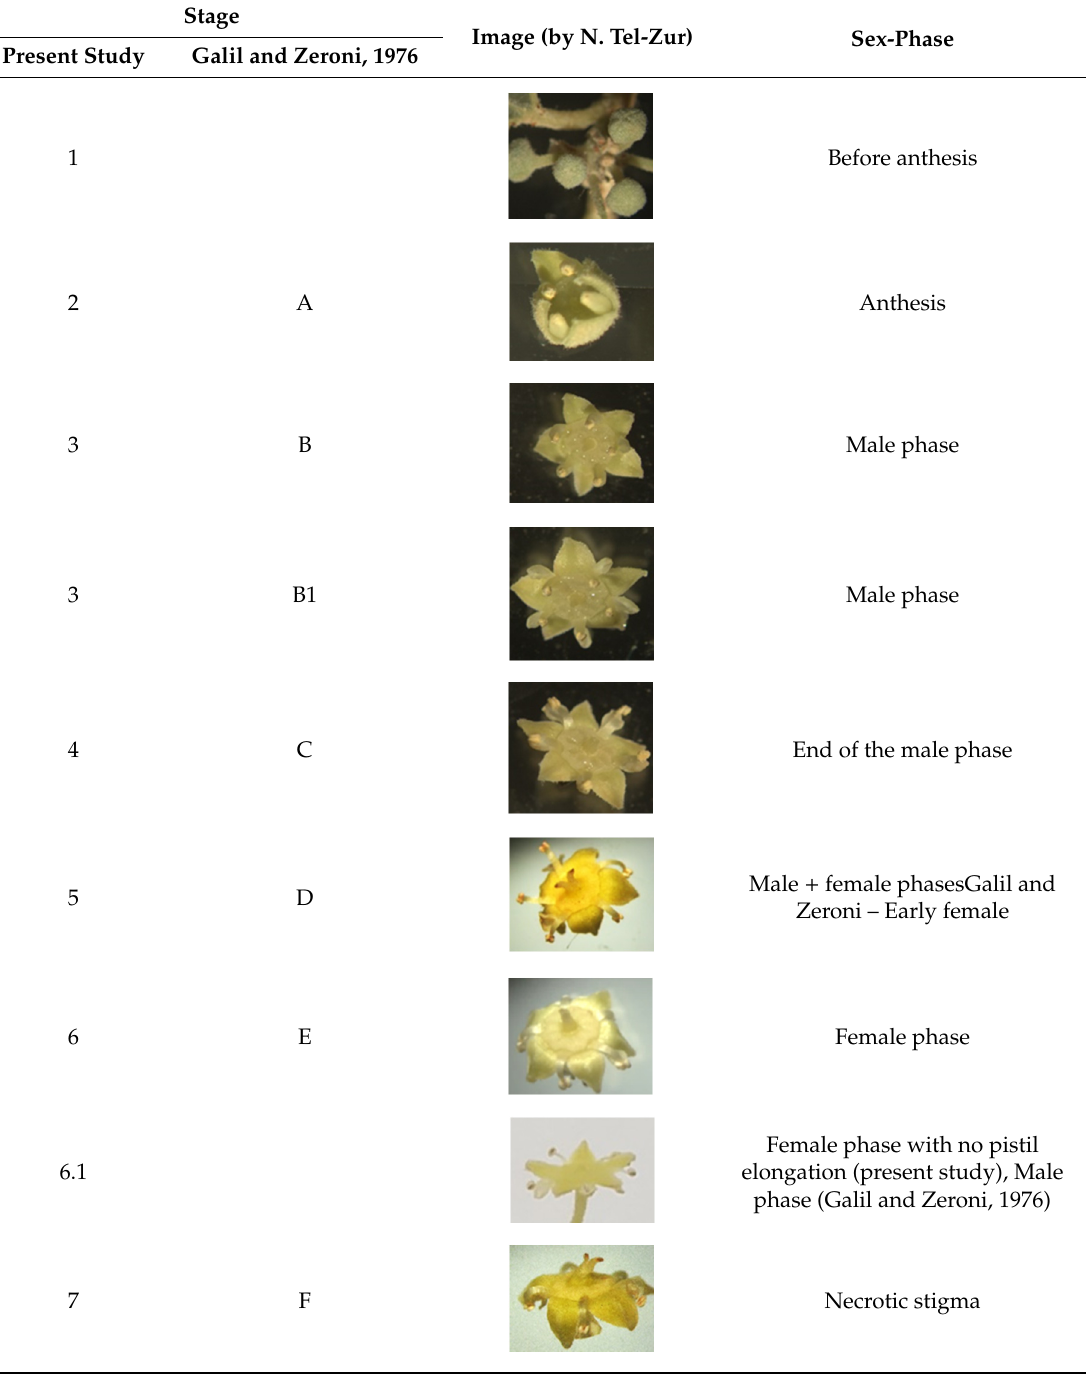
Table 1. Definition of floral stages in Ziziphus spina-christi.